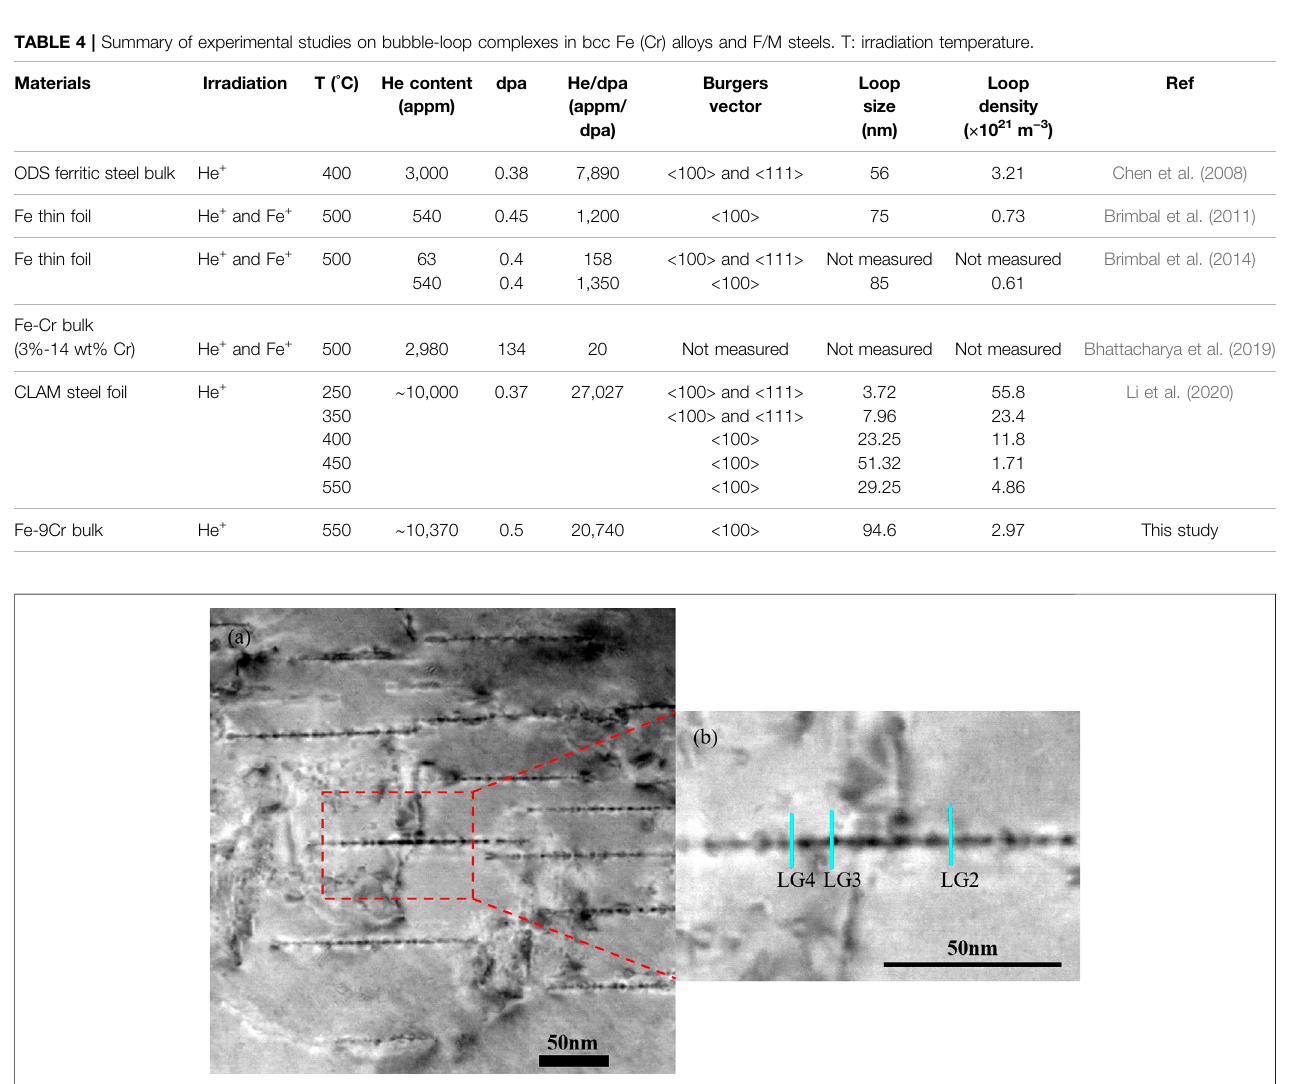
Frontiers in Energy Research |